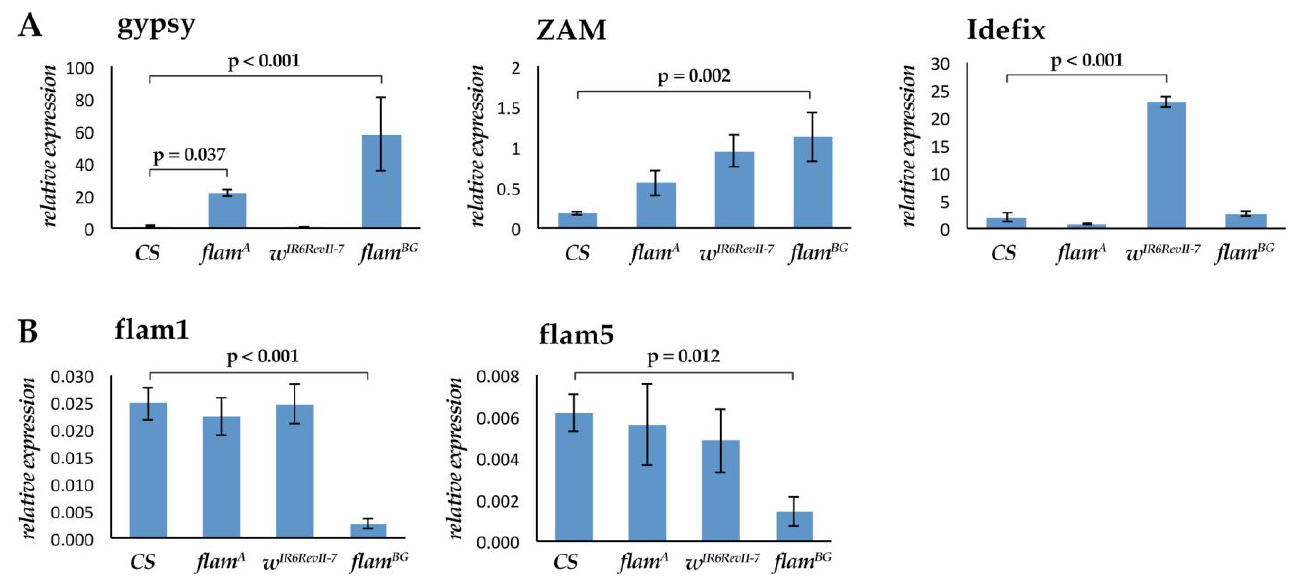
Figure 1. gypsy , ZAM and Idefix retrotransposons are under the regulation of flamenco in head somatic tissues. ( A , B ) Gene expression analysis in RNAs isolated from female head tissues from Canton S ( CS ), flam A /flam A , w IR6RevII7 /w IR6RevII7 and flam BG /flam BG strains. The fold changes indicate the expression levels relative to calibrator (gypsy in CS ). ( A ) Expression analysis of gypsy , ZAM and Idefix . ( B ) Expression analysis of flamenco . Shown are average levels ( n = 3), and error bars indicate SD. Significance was determined by one-way ANOVA with Tukey post hoc test.